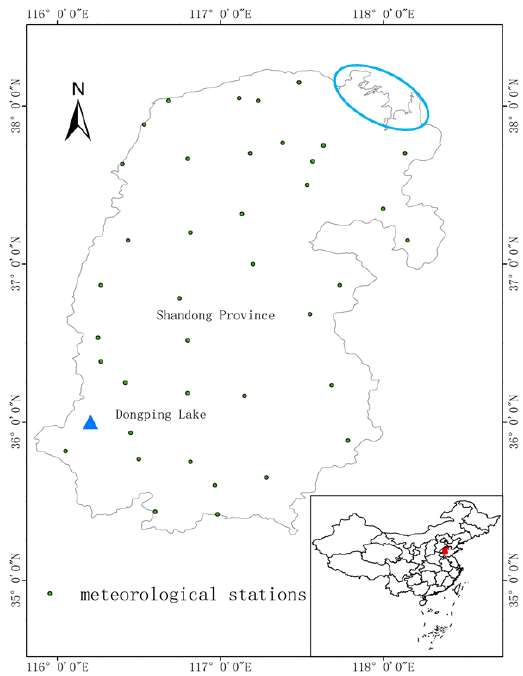
Figure 1. Study area and the distribution of the weather stations.